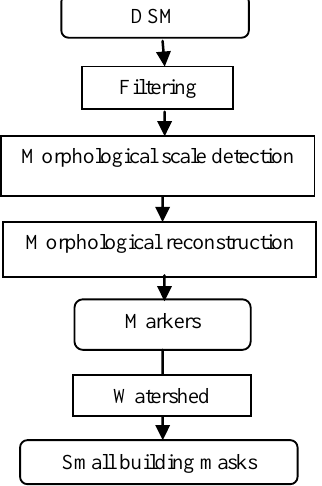
Figure 2 Flowchart of MM based mask extraction The smoothed DSM has been morphologically filtered to derive DTM and NDSM. A structure element (SE) of 100-by-100 was used to do opening to the smoothed DSM to get the DTM, and a SE of 60-by-60 was used to smooth the DTM. NDSM is derived by subtracting DTM from DSM. The pixels of the NDSM with values under zero are taken as the ground pixels. Others are taken as the off-terrain